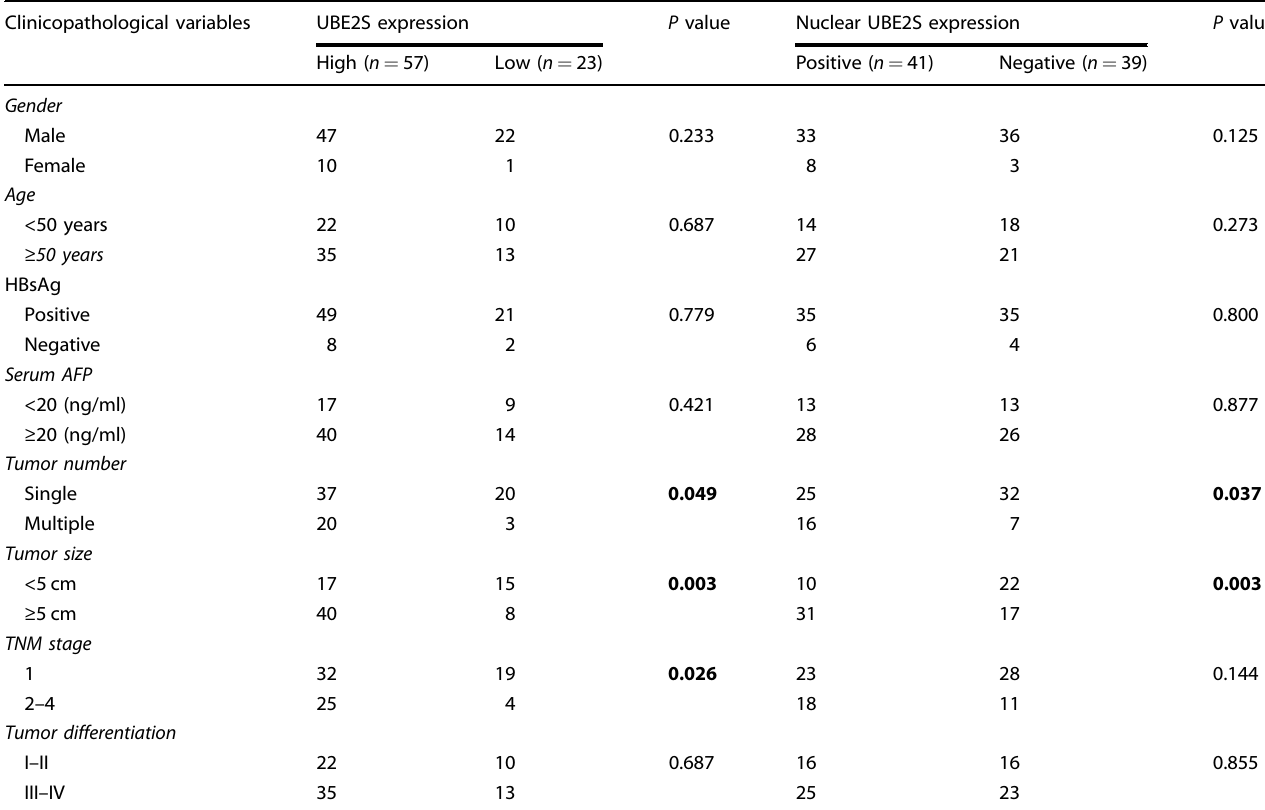
Table 1. Correlation of UBE2S expression and clinicopathologic features in patients with hepatocellular carcinoma Clinicopathological